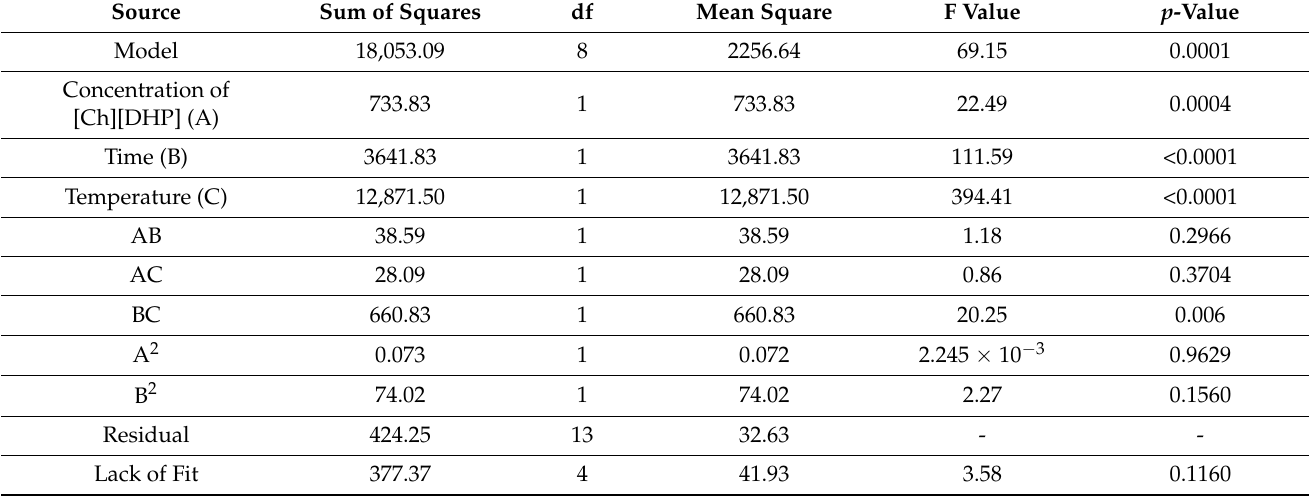
Table 4. ANOVA analysis for a response surface quadratic model for the percentage of hMBCOMT activity recovery. p -value < 0.05 is considered